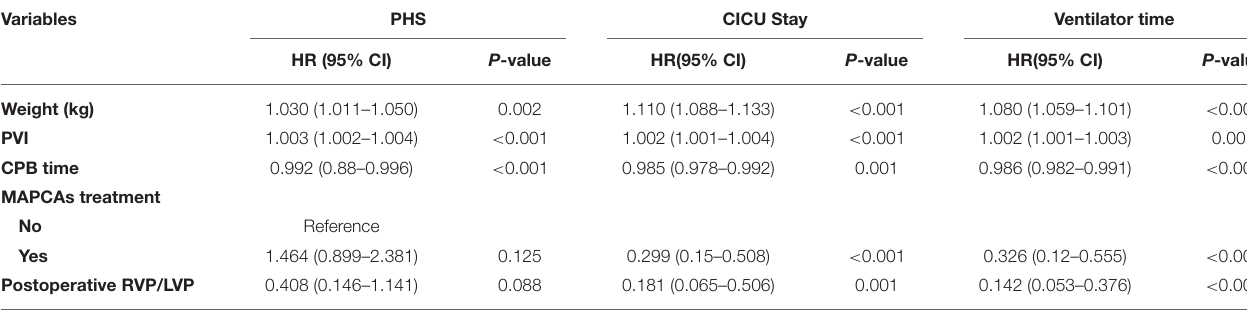
TABLE 4 | Multivariate analysis of risk factors for postoperative parameters.